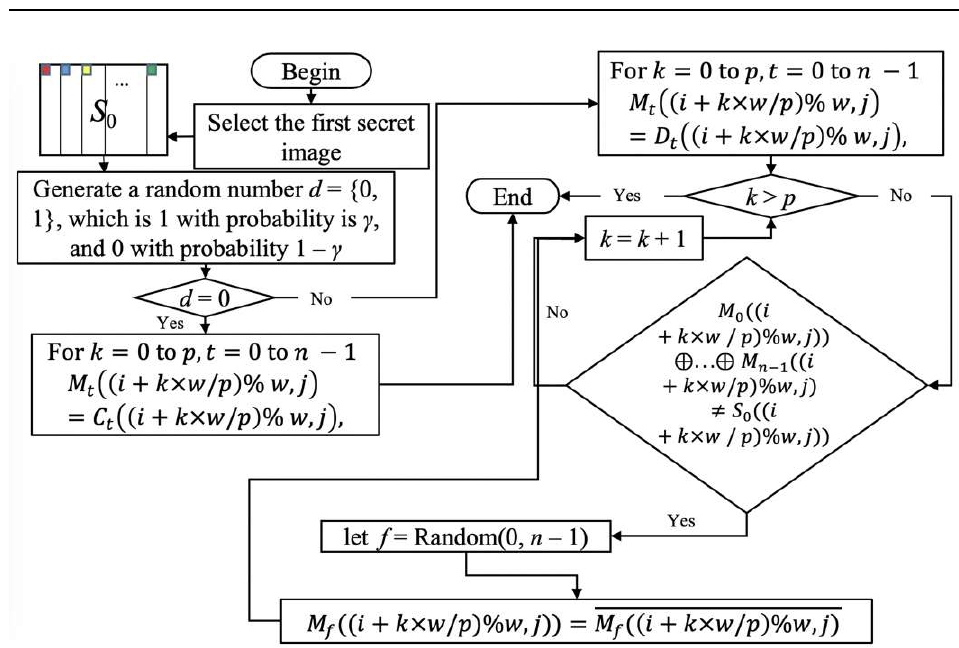
Figure 9. The flow chart of Method 3 Steps 1-3.